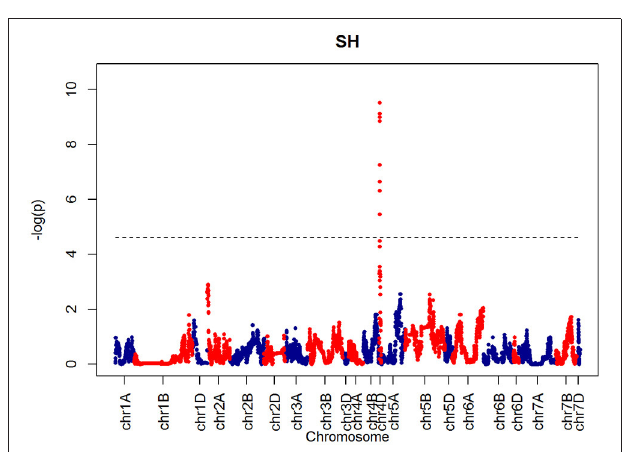
the earliest flowering parent, Soissons, which carries the Ppd-D1a allele for early flowering (Scarth et al.,